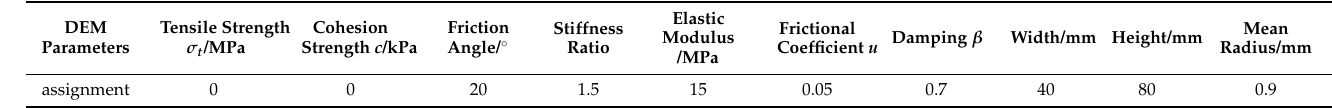
Table 4. Calibration results of remolded soils.